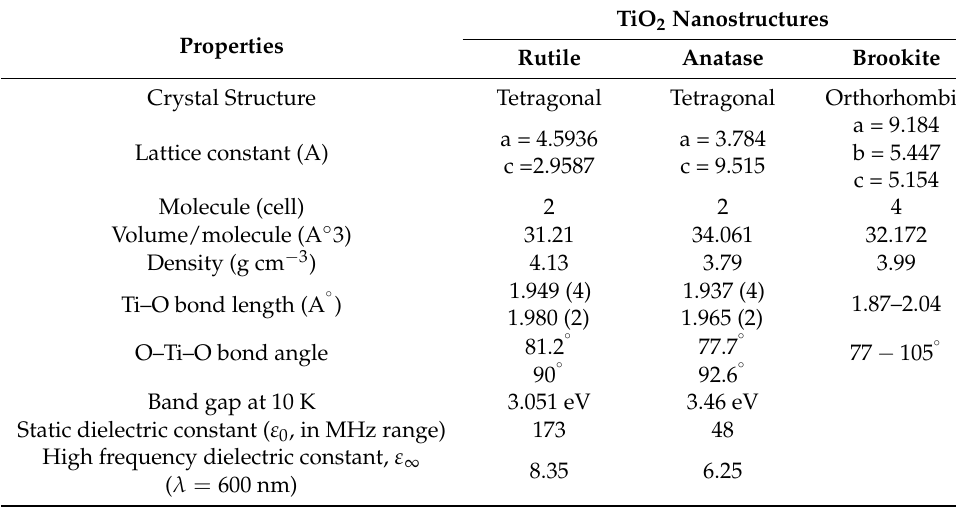
Table 2. Comparison of the crystal structural, optical and electrical properties for TiO 2 nanostructures. Adapted with permission from Ref. [102]. Copyright 2018, Royal Society of Chemistry.